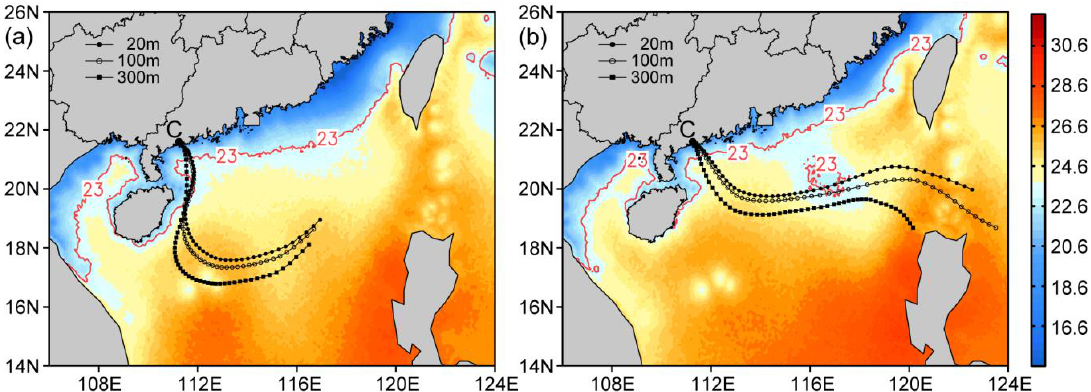
Figure 6. Airflow trajectories to inland site C with background of daily average sea-surface temperatures (°C). ( a ) Sea-surface temperature (SST) on March 10. Dotted lines denote 48 h backward trajectories of airflow at 20 m, 100 m, and 300 m heights from 0200 LST 11 March. ( b ) Same as ( a ), except SST on 30 March and trajectories from 0200 LST 31 March. SSTs are from real-time global data on 0.083° × 0.083° grid-spacing datasets.